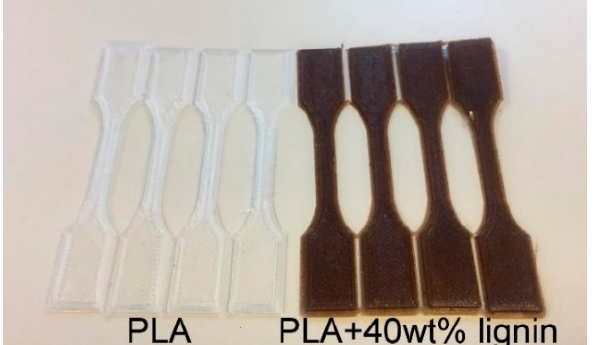
Figure 3. 3D printed dogbones for mechanical testing.